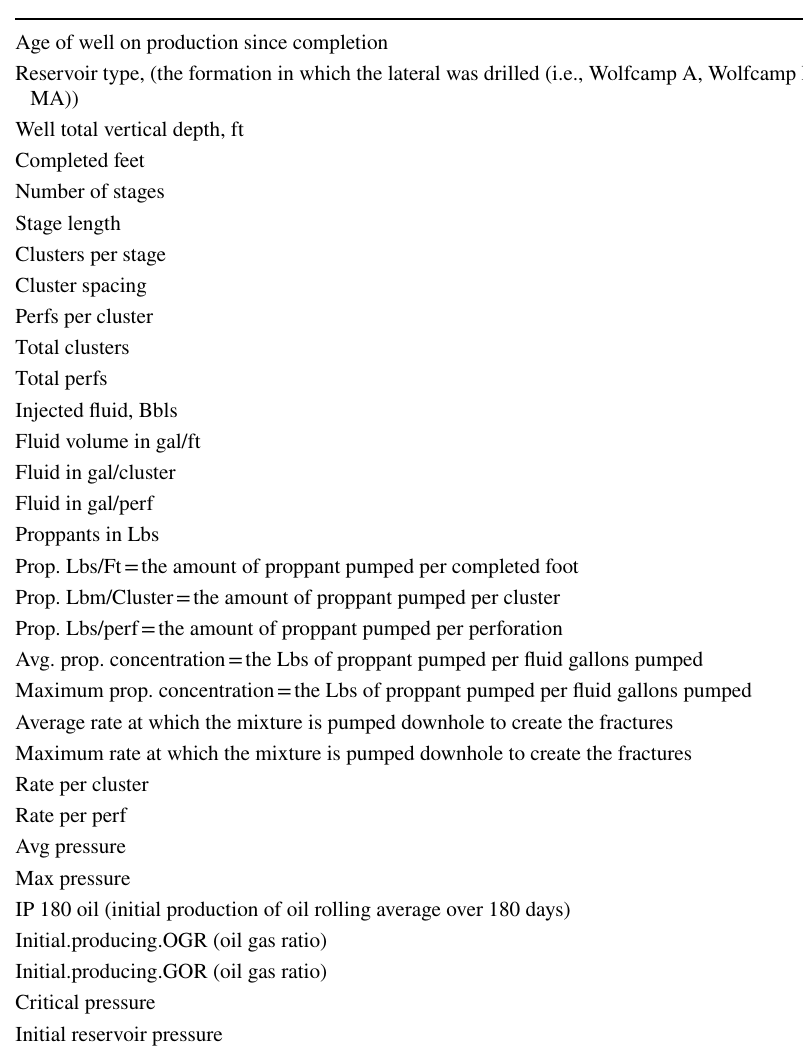
Table 3 List of chosen 32